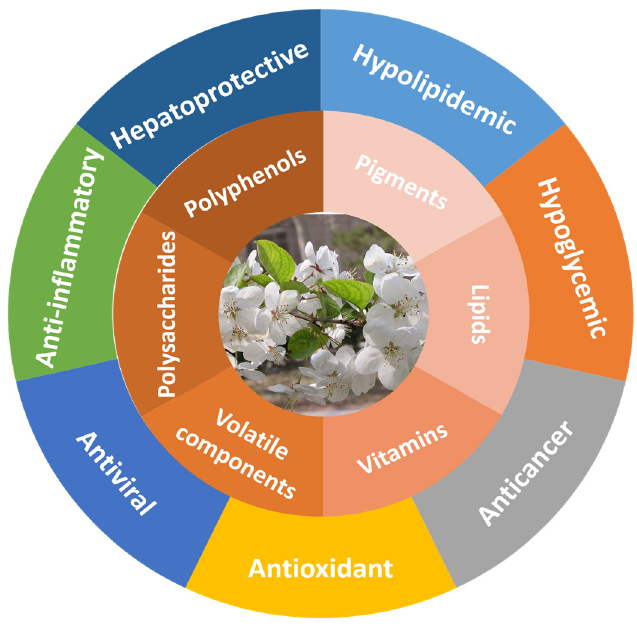
Figure 1. Bioactive substances and physiological activities of